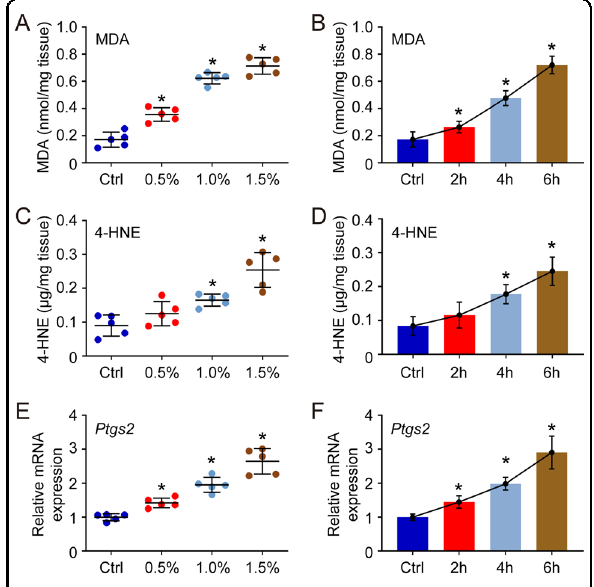
Fig. 1 Effect of iso fl urane exposure on ferroptosis in hippocampus. In does-dependent assay, the mice received 0.5%, 1.0% and 1.5% iso fl urane exposure for 6 h, while in time-dependent assay, the mice received 1.5% iso fl urane exposure for 2 h, 4 h and 6 h respectively. Then, all of mice were sacri fi ced immediately, and the hippocampus was isolated for different measurements. Herein, the level of MDA ( A , B ) and 4-HNE ( C , D ), as well as the expression of Ptgs2 ( E , F ), were measured to evaluate the ferroptosis in each group. * p value < 0.05 compared with the Ctrl